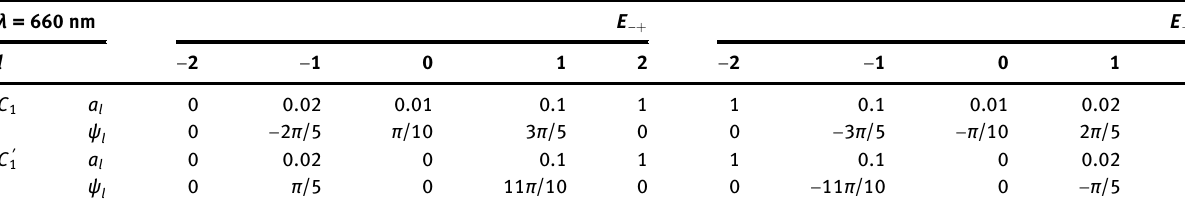
Table  : Table of l th order expansion coef fi cient for λ (cid:2)  nm. λ =  nm E −